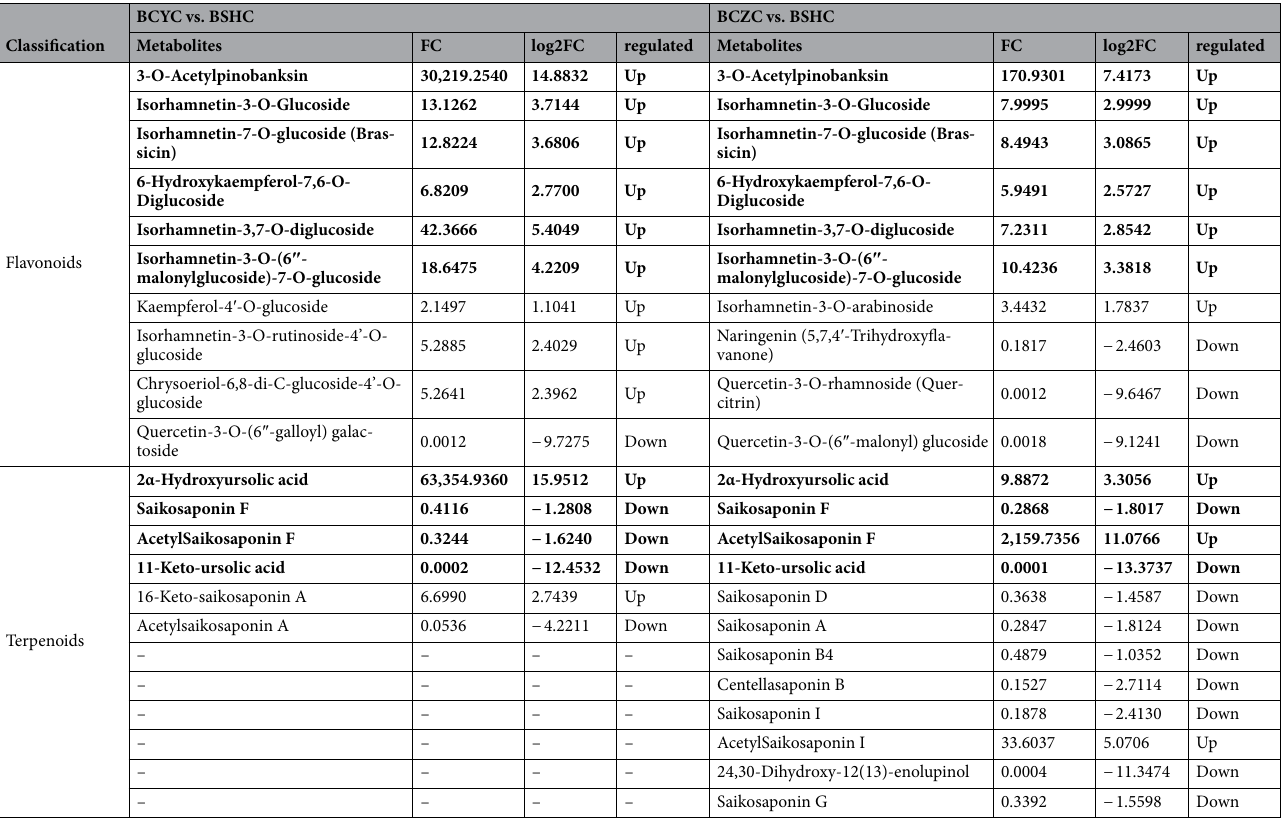
Table 1. Comparison of differential metabolites (flavonoids and terpenoids) between B. chinense and B. scorzonerifolium. (Metabolites were bold which were identical between BCYC vs. BSHC and BCZC vs. BSHC; the parameters used to select differential compounds were FC > 1, P -value < 0.05 and VIP >